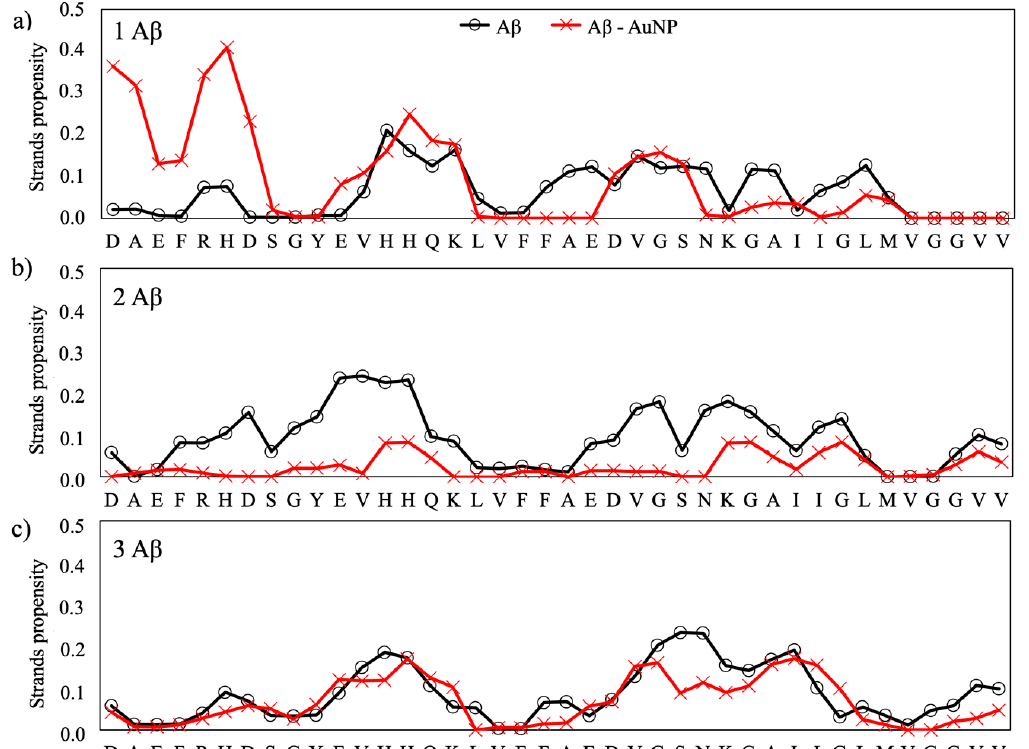
Figure 4. β -strand propensity for each residue of the A β (1–40) peptides for the three ratios: 1:1 ( a ), 2:1 ( b ) and 3:1 ( c ). Int. J. Mol. Sci. 2020 , 21 , x FOR PEER REVIEW